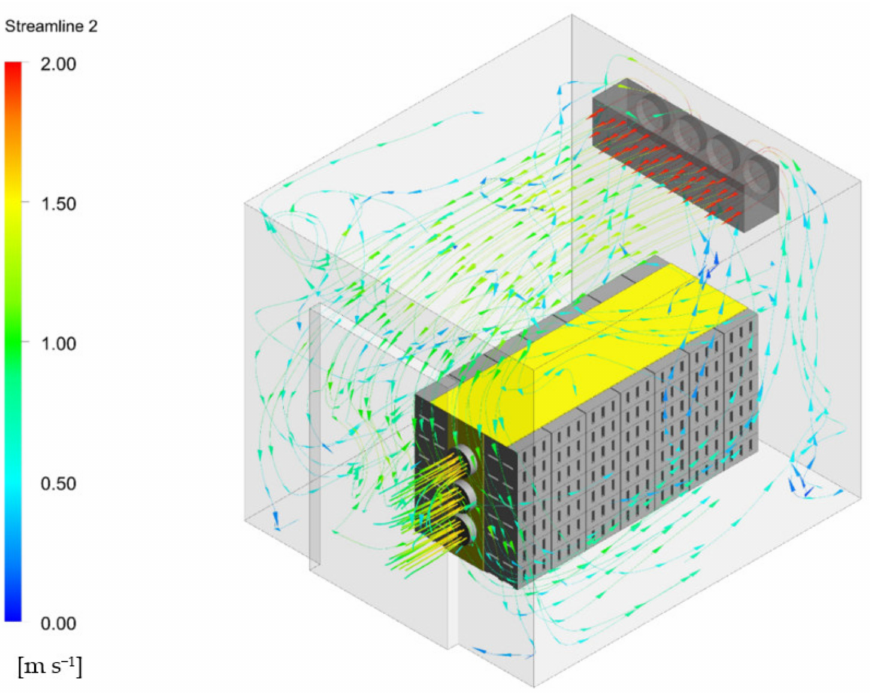
Figure 2. Configuration of precooling tunnel.